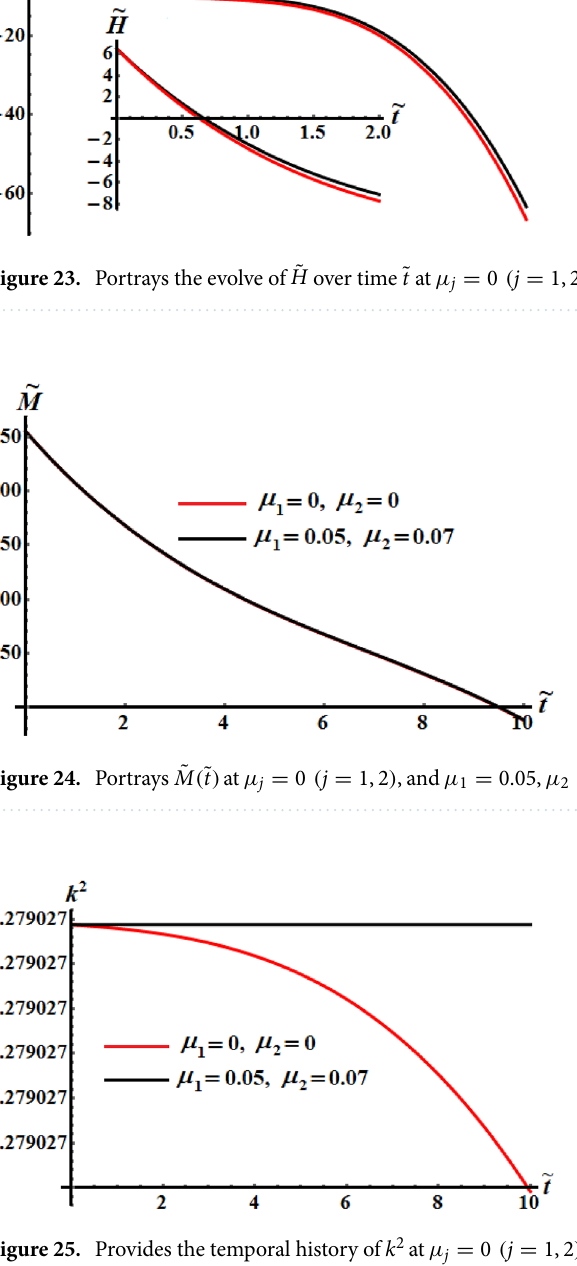
Figure 25. Provides the temporal history of k 2 at µ j = 0 ( j = 1, 2 ) , and µ 1 = 0.05, µ 2 =